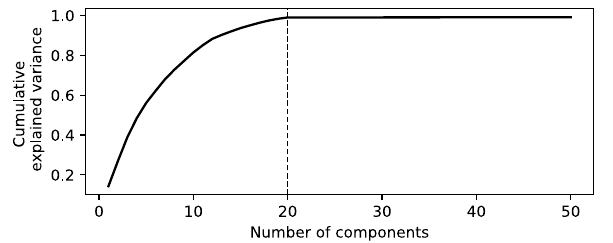
Figure 2. Cumulative percentage of variance explained by the first 50 components of the EOFs decomposition for the simulated dataset. As expected from the data generating process, the sum of the relative variances of the 20 first components reach the total variance of the